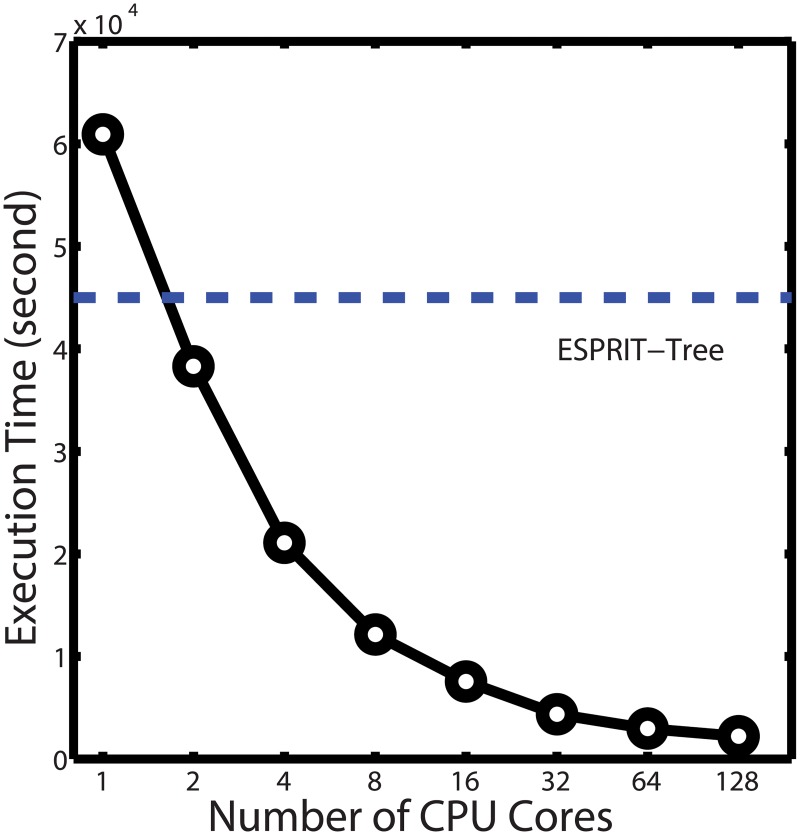
Execution time of ESPRIT-Forest performed on a human gut microbiome dataset using a varying number of CPU cores ranging from 1 to 128.The clustering termination criterion was set to 85% sequence similarity. For comparison, the execution time of ESPRIT-Tree is also reported.